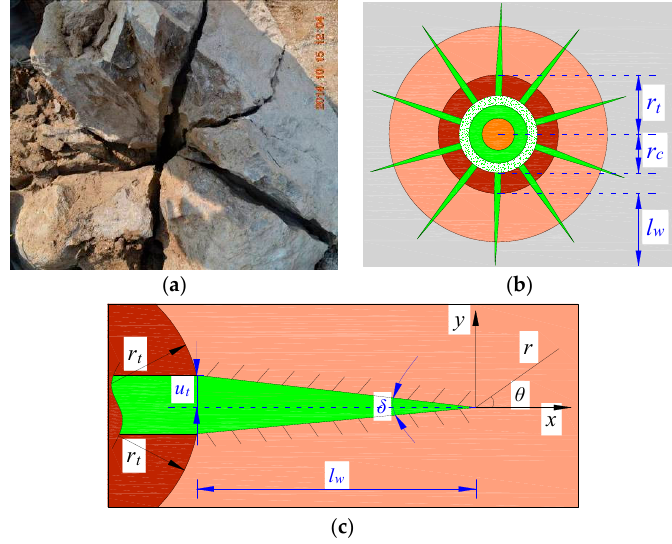
Figure 7. Model of fracture propagation after confined blasting in a water-filled deep hole: ( a ) Effects of deep-hole rock blasting; ( b ) Propagation of fractures in surrounding rock; ( c ) Propagation of a single fracture.